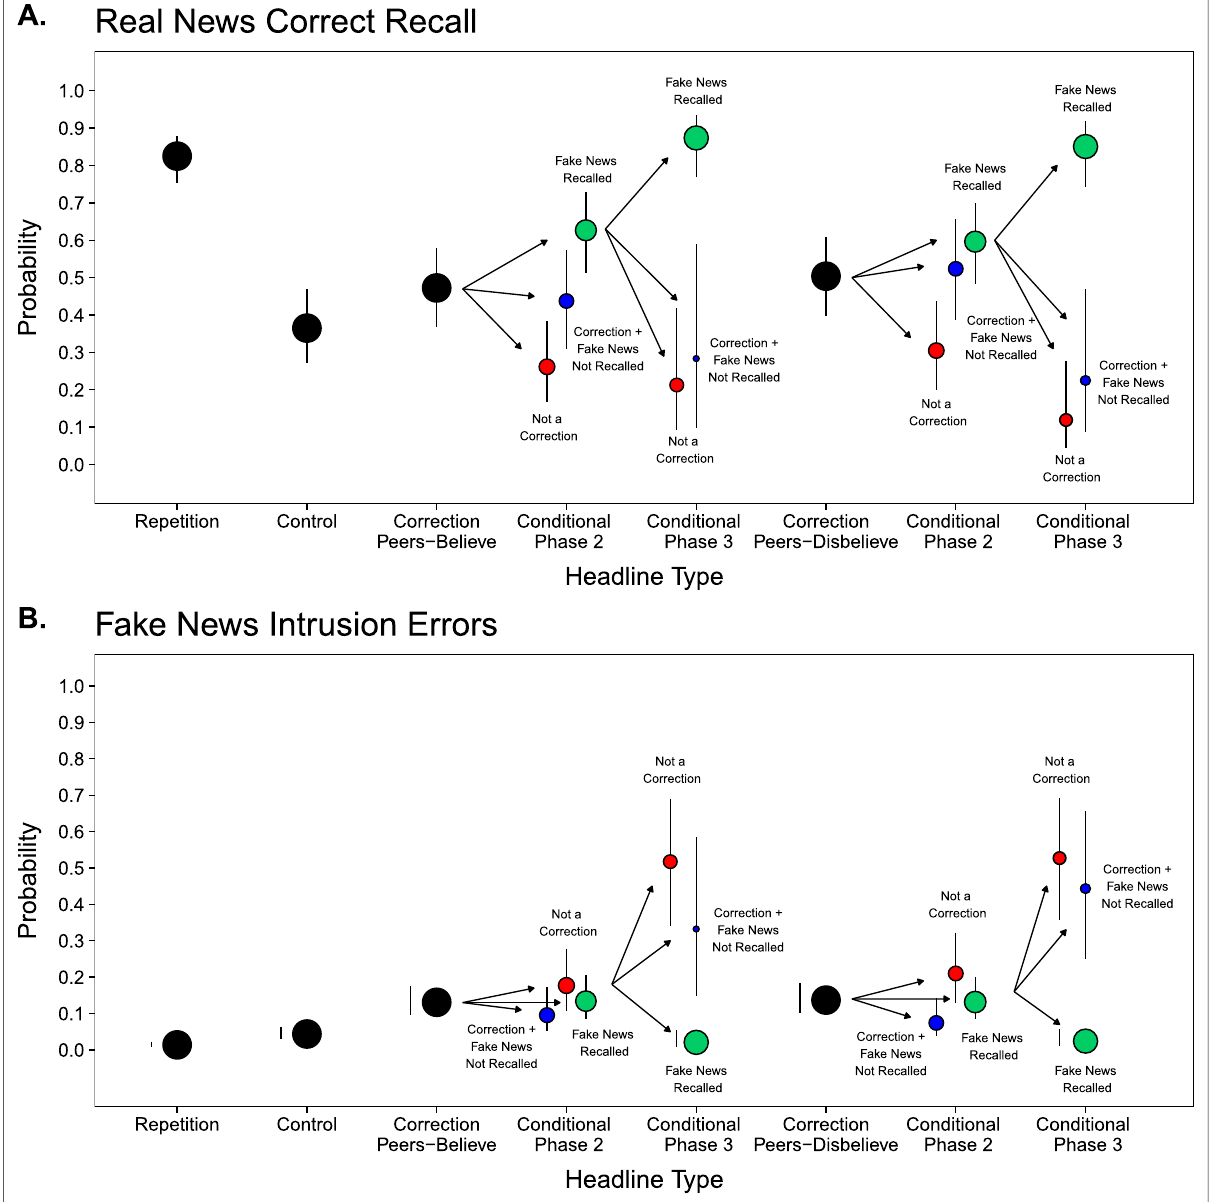
Fig. 3 Recall of Real News and Intrusions of Fake News: Experiment 2. Probabilities of real news correct recall (Panel A) and fake news intrusion errors (Panel B) as a function of Headline Type in Experiment 2. Black points represent probabilities for all observations. Colored points represent probabilities conditioned on correction classification types in Phases 2 and 3. The cells represent corrections that were classified as such and for which fake news was recalled (green points), corrections that were classified as such and for which fake news was not recalled (blue points), and corrections that were not classified as such (red points). The size of each point indicates the relative proportion of observations in each cell. Error bars are 95% confidence intervals and are displayed adjacent to the points when the intervals lengths are shorter than point